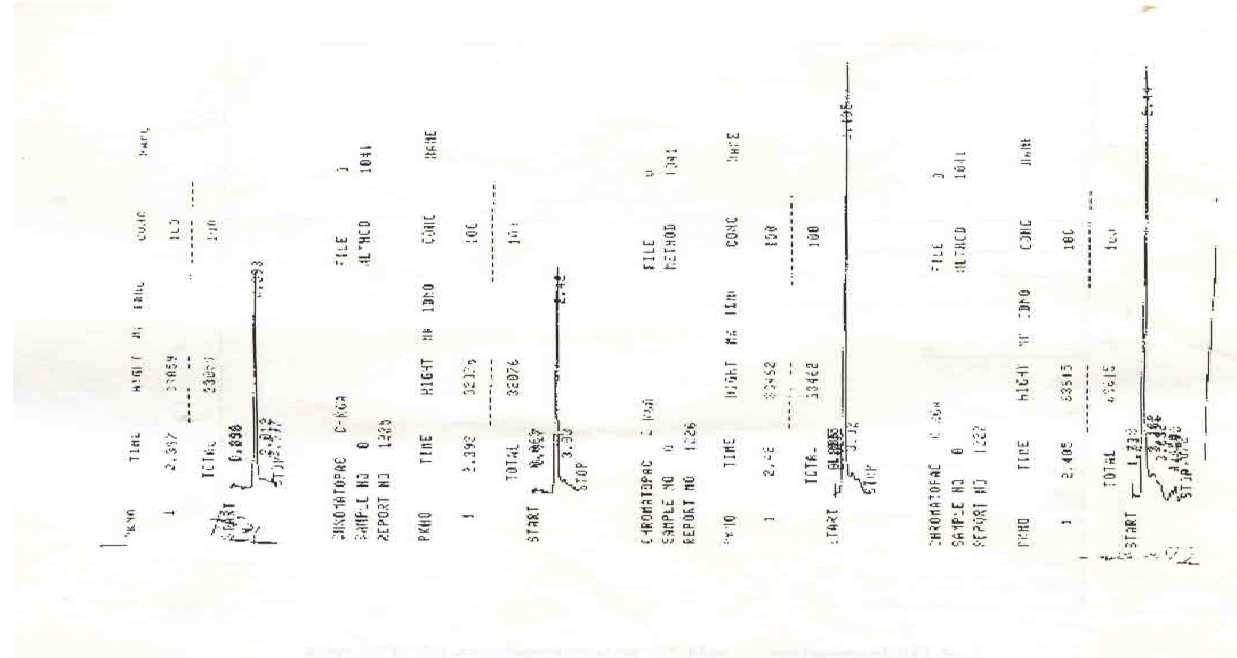
Fig.(1c) HPLC for a mixture of equal quantities of the compound (BA 1 ) and the